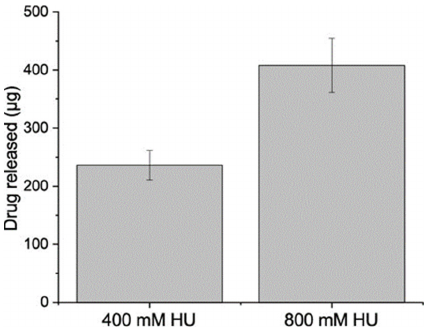
Table 1. pH measurements of starting concentration for the synthesis.